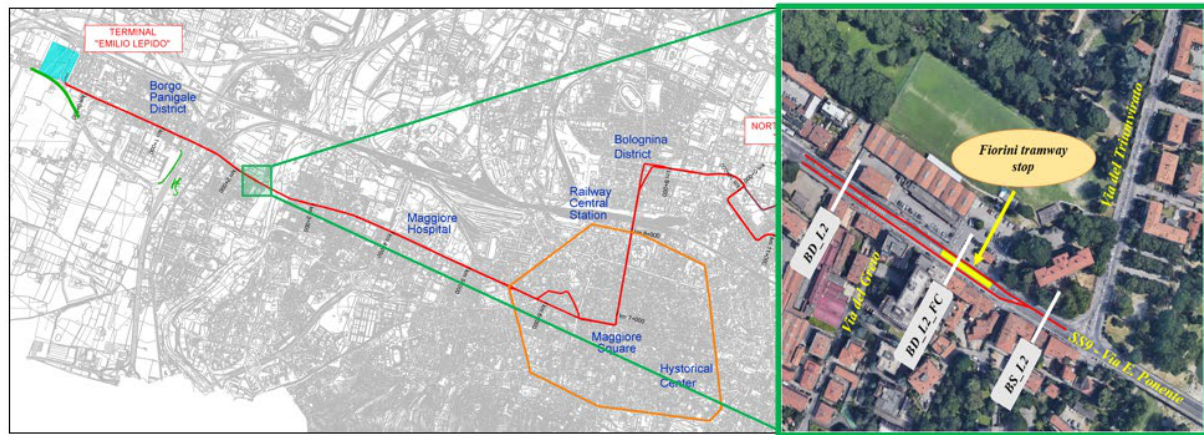
Figure 1. “Fiorini” tramway stop’s location along the Bologna’s Red Tramway Line. Figure 2 defines the analysis performed step-by-step.